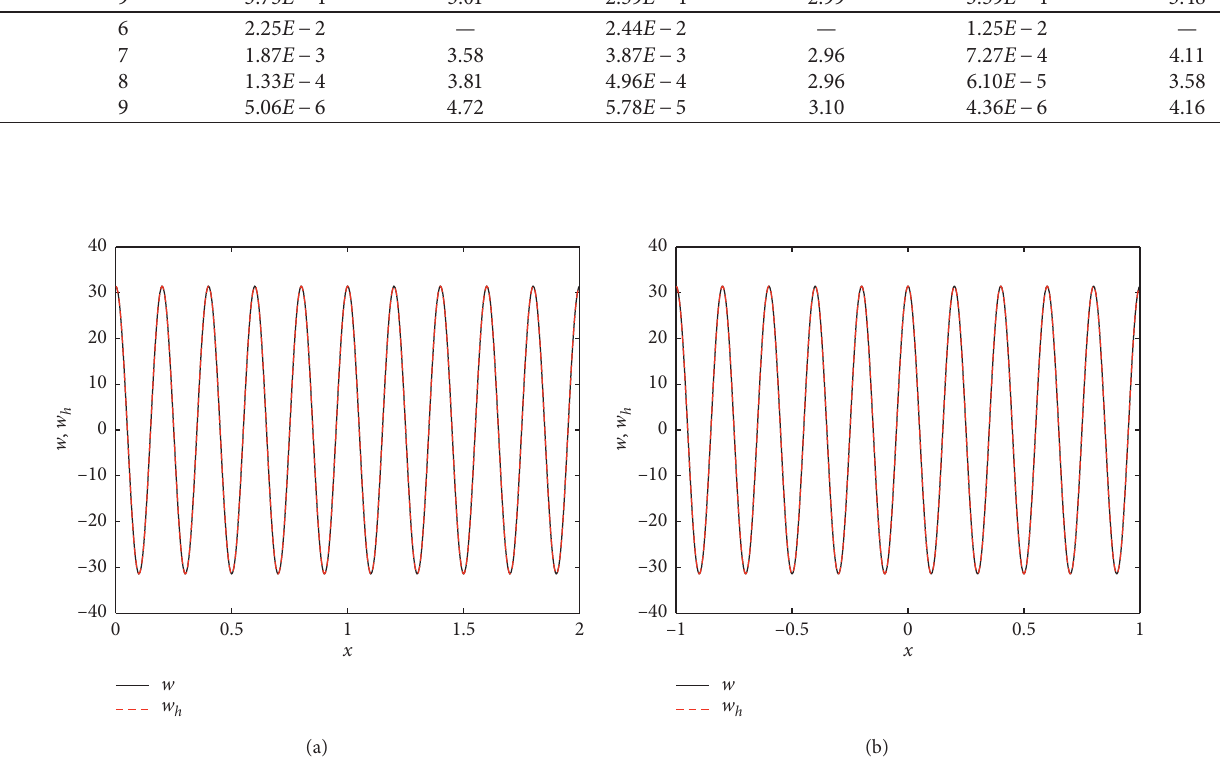
T � 100 by P 2 (a) and P 3 (b) for Example 1. h (dashed red dots) at